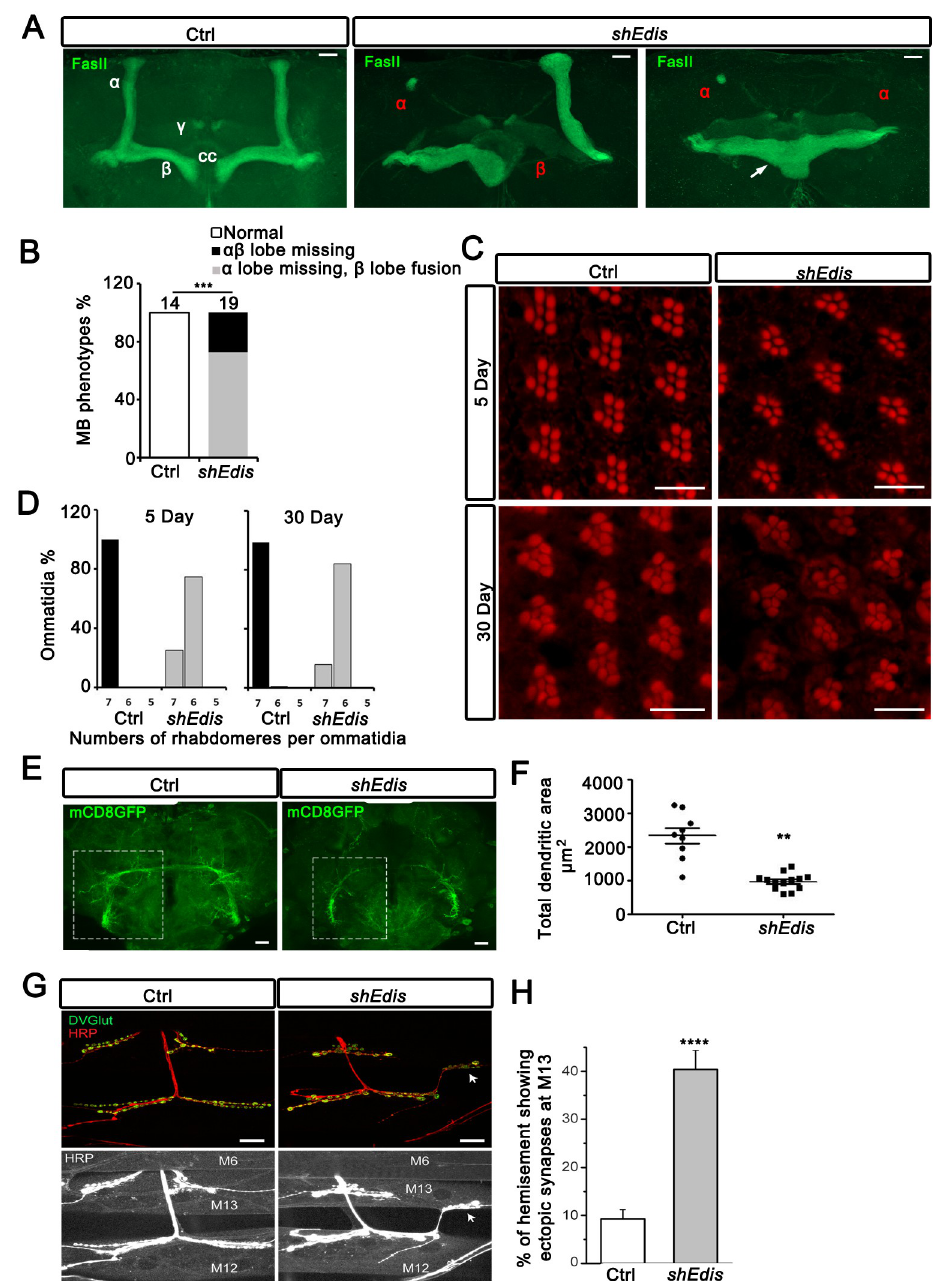
Fig 5. Neuron-specific depletion of Edis causes abnormal axonogenesis and neurodevelopment. (A) Confocal images of dorsal anterior regions of adult brains with neuron-specific expression of control shgfp (left panel) or shEdis (middle and right panels) driven by Elav-Gal4 driver. In control brain (left panel), anti-FasII antibody delineates the central complex (CC) as well as the vertical α and horizontal β and γ lobes of the mushroom bodies ( MB s), with γ lobes showing weaker FasII signal, as indicated. Depletion of Edis resulted in a spectrum of severe, age-dependent morphological defects in the MBs. In middle panel, one α lobe and one β lobe were mostly missing, and the remaining α and β lobes showed abnormal morphology. In right panel, both α lobes were largely missing, while the two β lobes crossed the midline and merged together. Scale bar: 20 μ m. (B) Quantification of MB morphology phenotypes shown in A (Chi-squared test, sample numbers are shown on top, ��� p < 0.001). ( C ) To deplete Edis in the eye, GMR-Gal4 was used to drive shEdis transgene expression. The adult eyes of Ctrl and GMR > shEdis flies were analyzed by phalloidin staining (red) at day 5 or day 30 after eclosion. Scale bar: 10 μ m. ( D ) Images of the 5-day- or 30-day-old fly eyes with the indicated genotypes were quantified and shown as the percentage of ommatidia with the